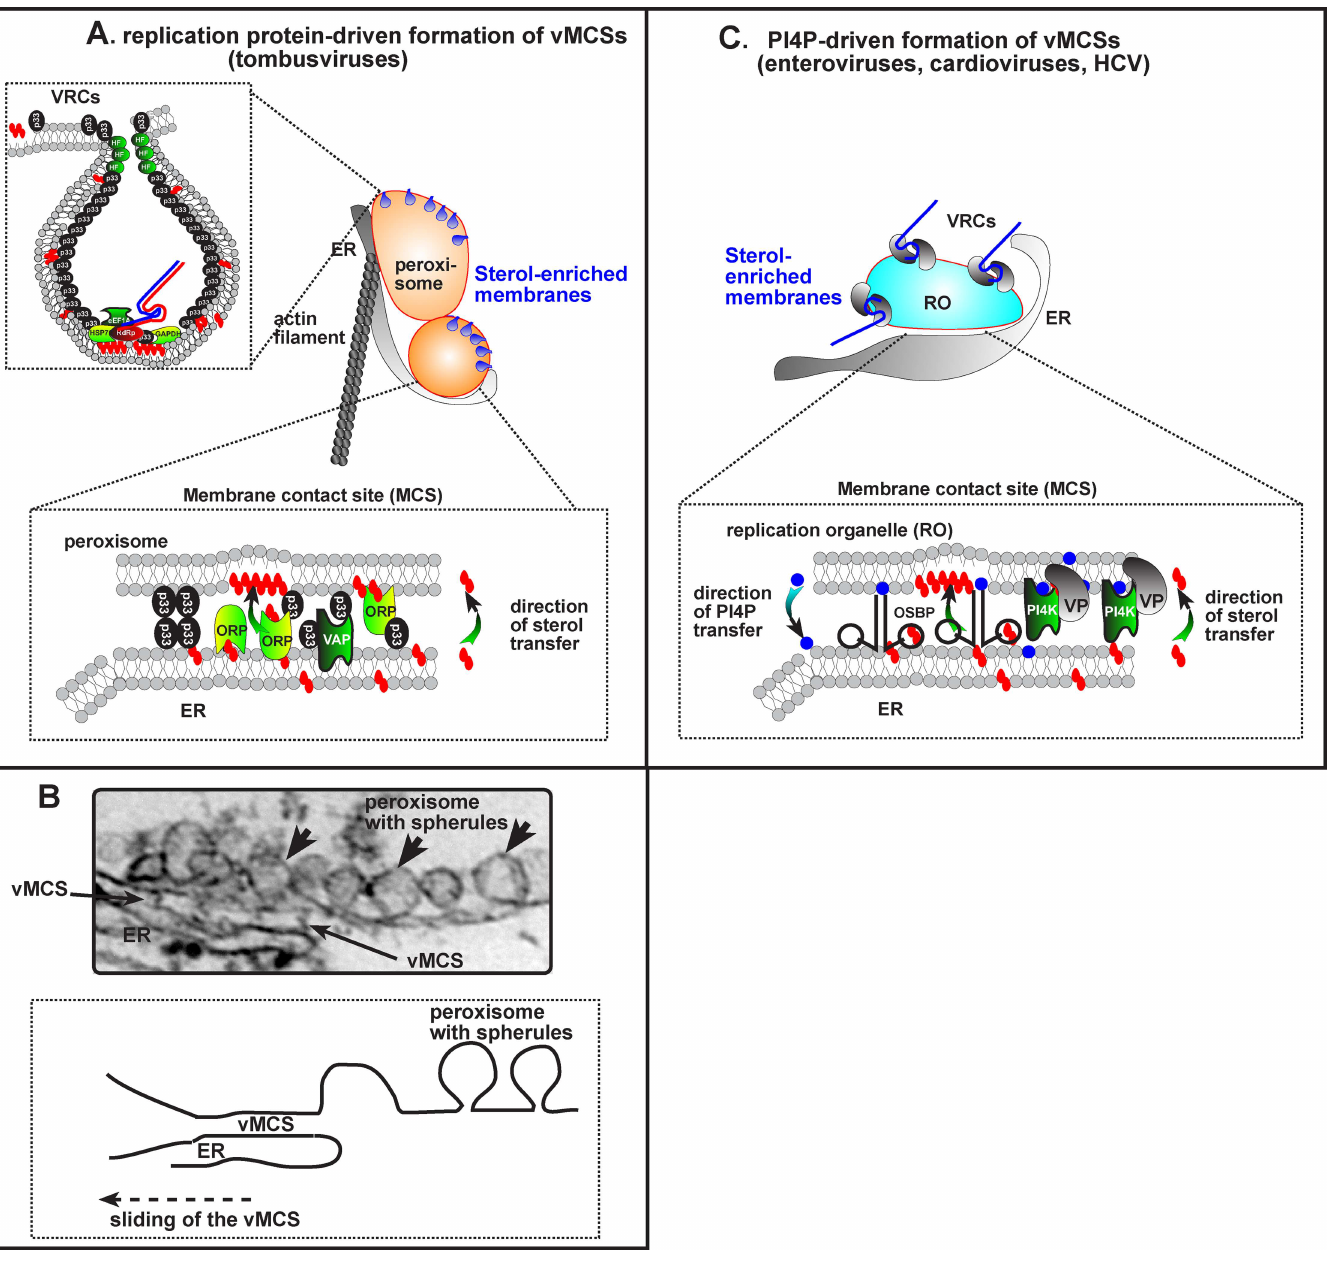
Fig 1. VMCSs promote the morphogenesis and functioning of viral replication organelles. (A) The formation of invagination-type replication organelles is driven by vMCSs through direct protein–protein interactions of a viral replicationprotein (e.g., TBSV p33) with cellular ORPs and the ER residentialVAPs. The vMCS, which is likely stabilized by co-opted actin filaments, facilitates the enrichment of sterols in the peroxisomal membrane. (B) An electron microscopic (EM) image of a vMCS and multiple vesicle-likestructures (spherules),each of which harbors a viral replicase complex (VRC), which replicates the viral genome, is shown from a TBSV-infected plant cell [13]. We proposethat the vMCS forms transiently between two subdomains of apposingmembranes, locally enrichingsterols, then slidingonto new neighboring subdomains of the same organelles, thus acting as a molecular assembly line. (C) vMCSs between protrusion-type replicationorganelles and the ER dependon the recruitment of PI4Ks by VPs. At the replication organellemembranes, PI4Ks produce PI4P lipids to recruit OSBP. Then, OSBP mediates the accumulation of cholesterolin replicationorganelle membranesin a counter-exchange with PI4P, which is hydrolyzedafter delivery at the ER by Sac1 phosphatase [10]. OSBP is naturally anchored to the ER by VAPs, which for some viruses are known to interact with VPs (see text).